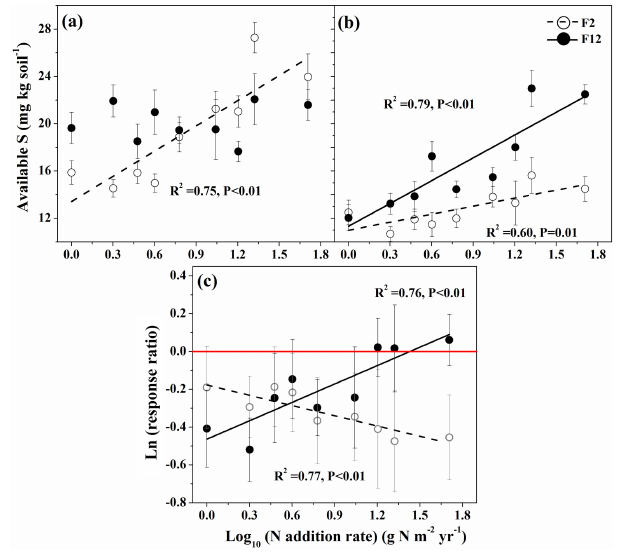
Figure 3. Effects of N addition intensity and frequency on soil- available S concentration in unmown (a) and mown plots (b) , and response ratio of soil-available S to mowing along the N addition rate (c) . Dashed and solid regression lines represent 2 and 12N ad- ditions per year, respectively. Error bars indicate standard errors in (a) and (b) , and 95% confidence intervals in (c)